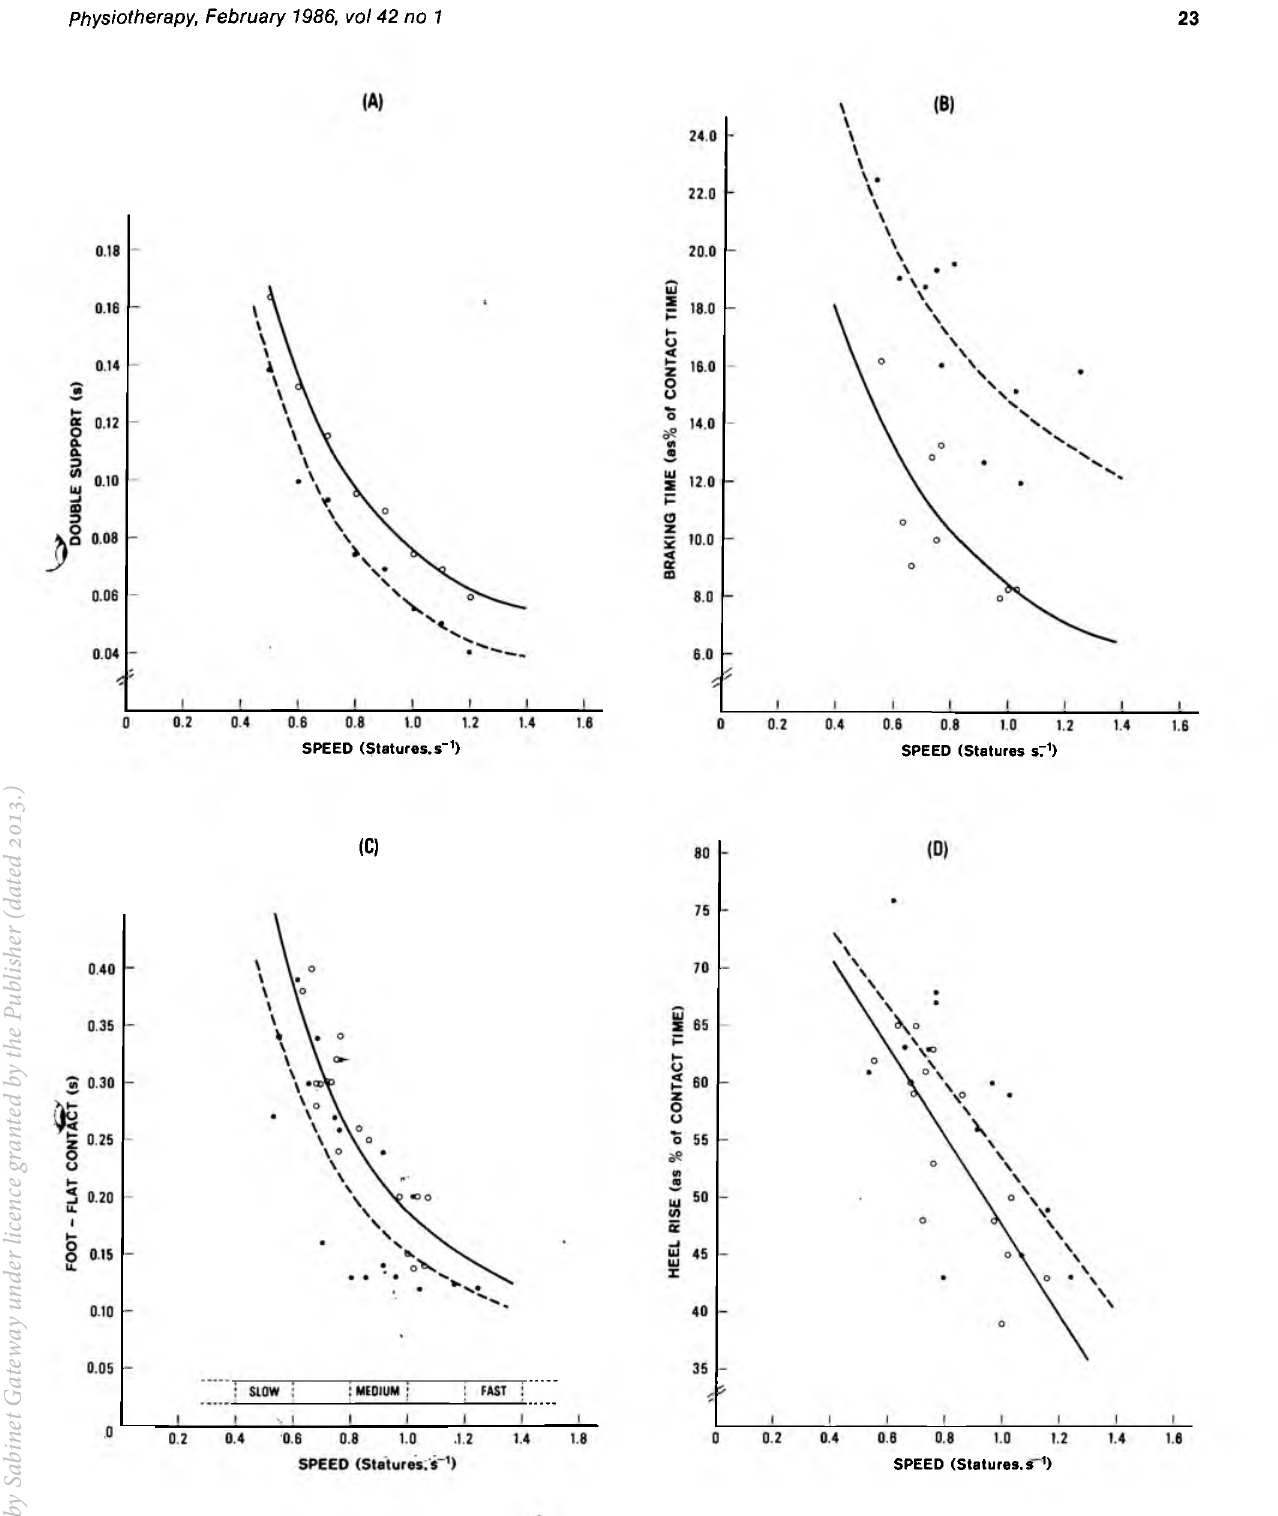
Fig. 5. Breakdown o f foot-floor contact components. Broken line represents unloaded condition; solid line represents loaded